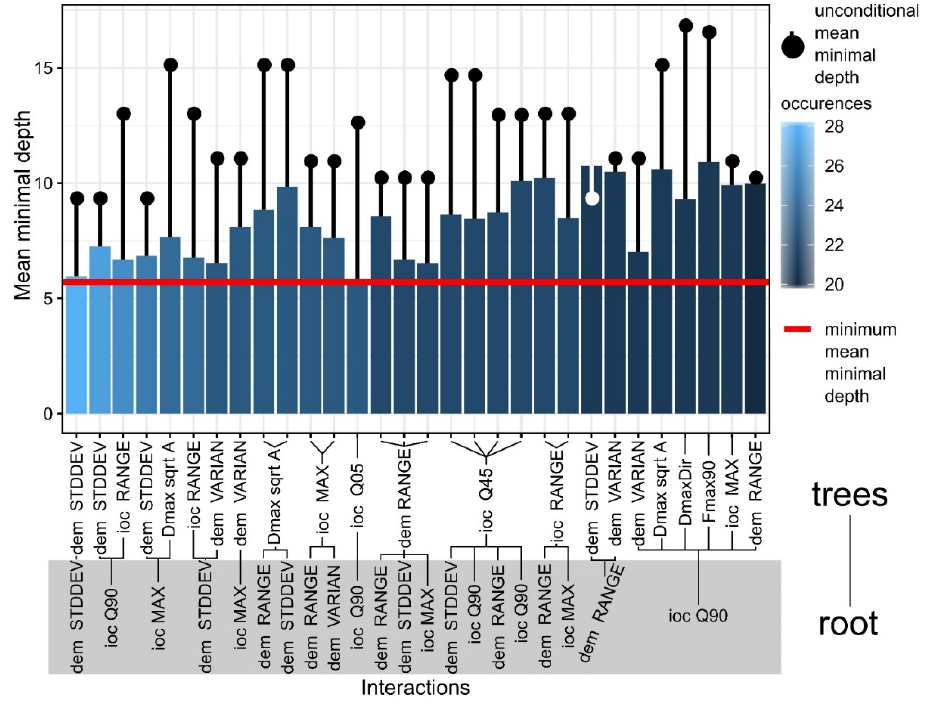
Figure 13. Mean minimal depth for the 30 most frequent interactions. (a high-resolution version can be found at https://doi.org/10.6084/m9.figshare.11798679)